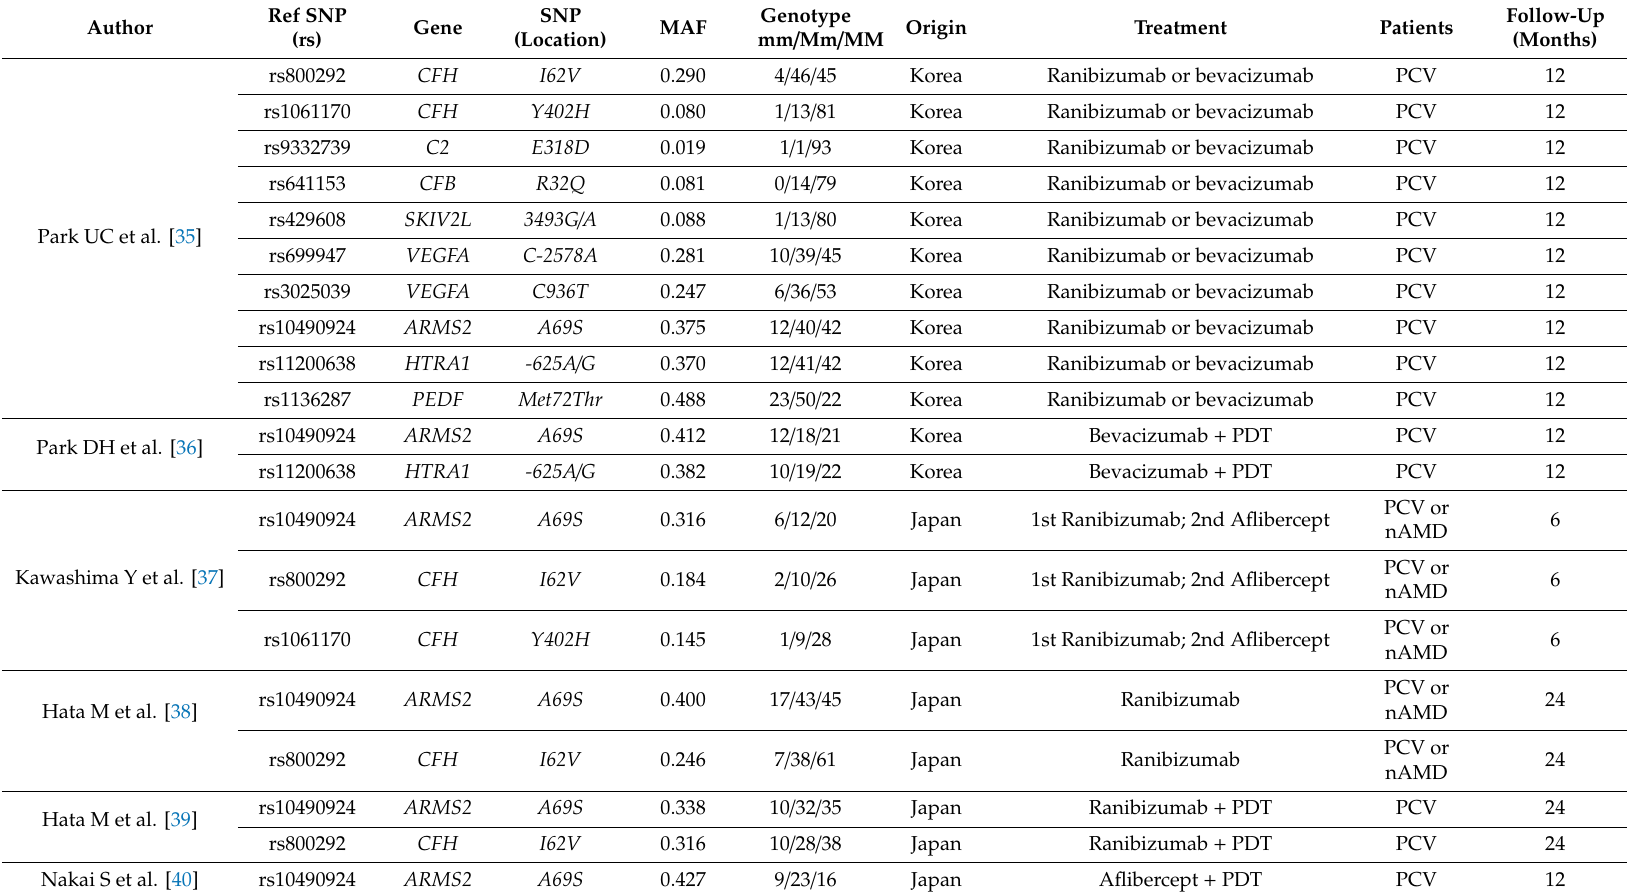
Table 2. Genetic variants and population characteristics of included